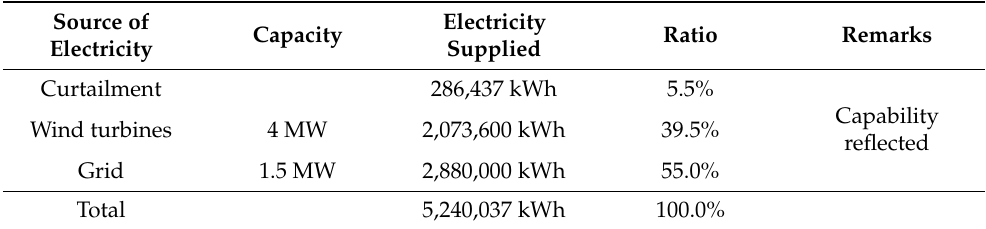
Table 25. The annual amount of electricity to be supplied to water electrolysis (Scenario IV).